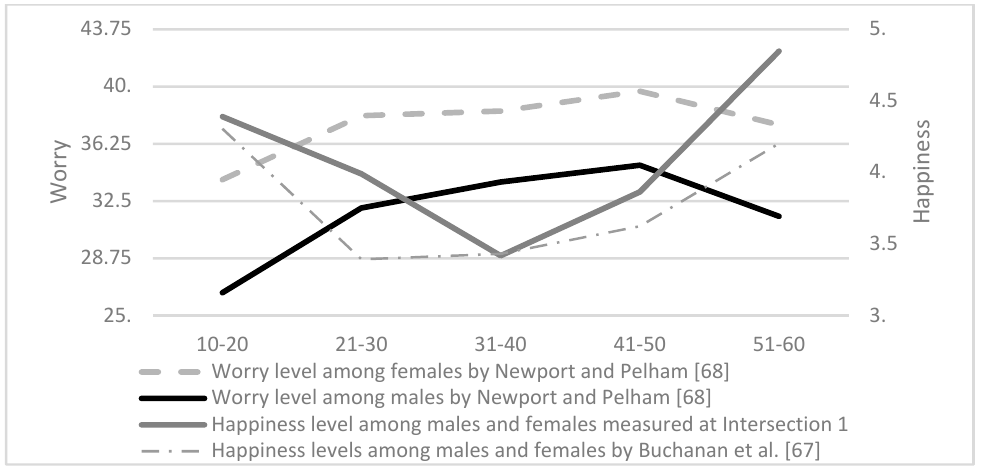
Figure 4. U-shaped happiness levels among males and females measured at Intersection 1 and by Buchanan et al. [67]. Inversely U-shaped worry levels among males and females by Newport and Pelham [68].